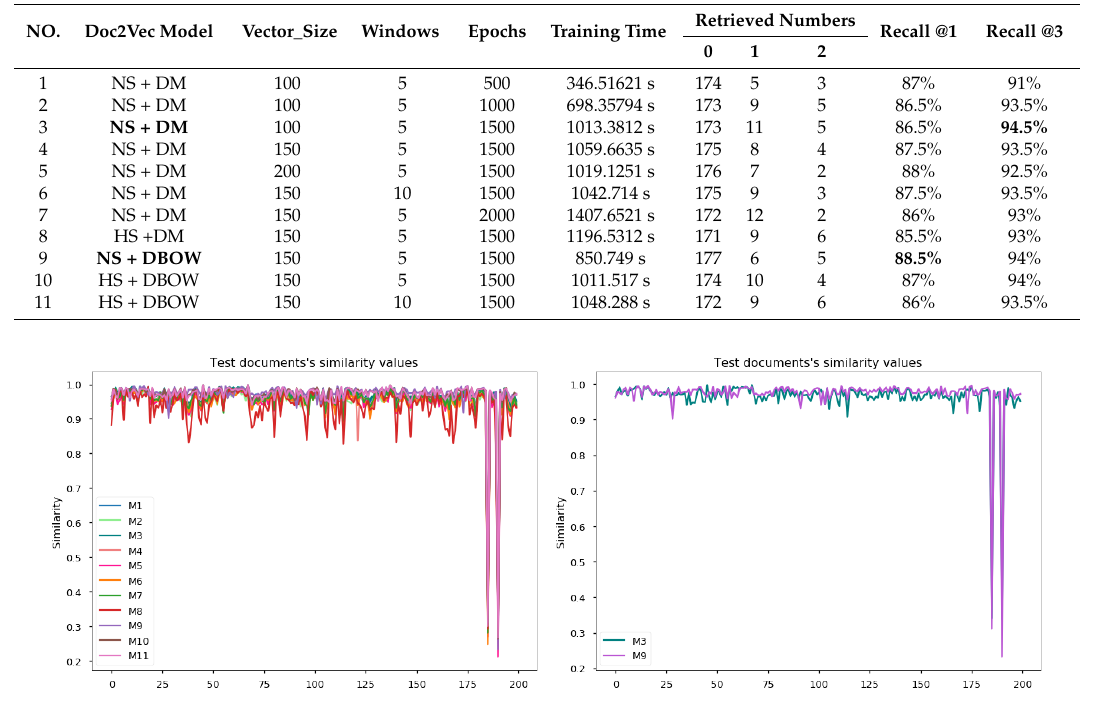
Figure 9. Test Results of Doc2Vec